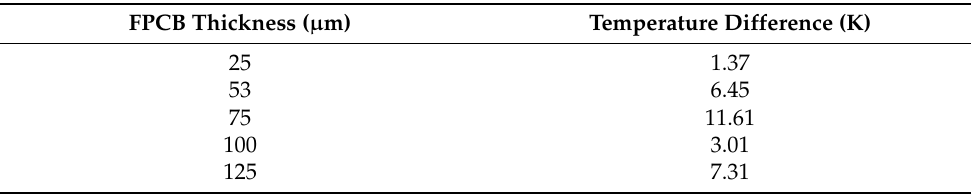
Table 3. Temperature difference for different FPCB thicknesses.